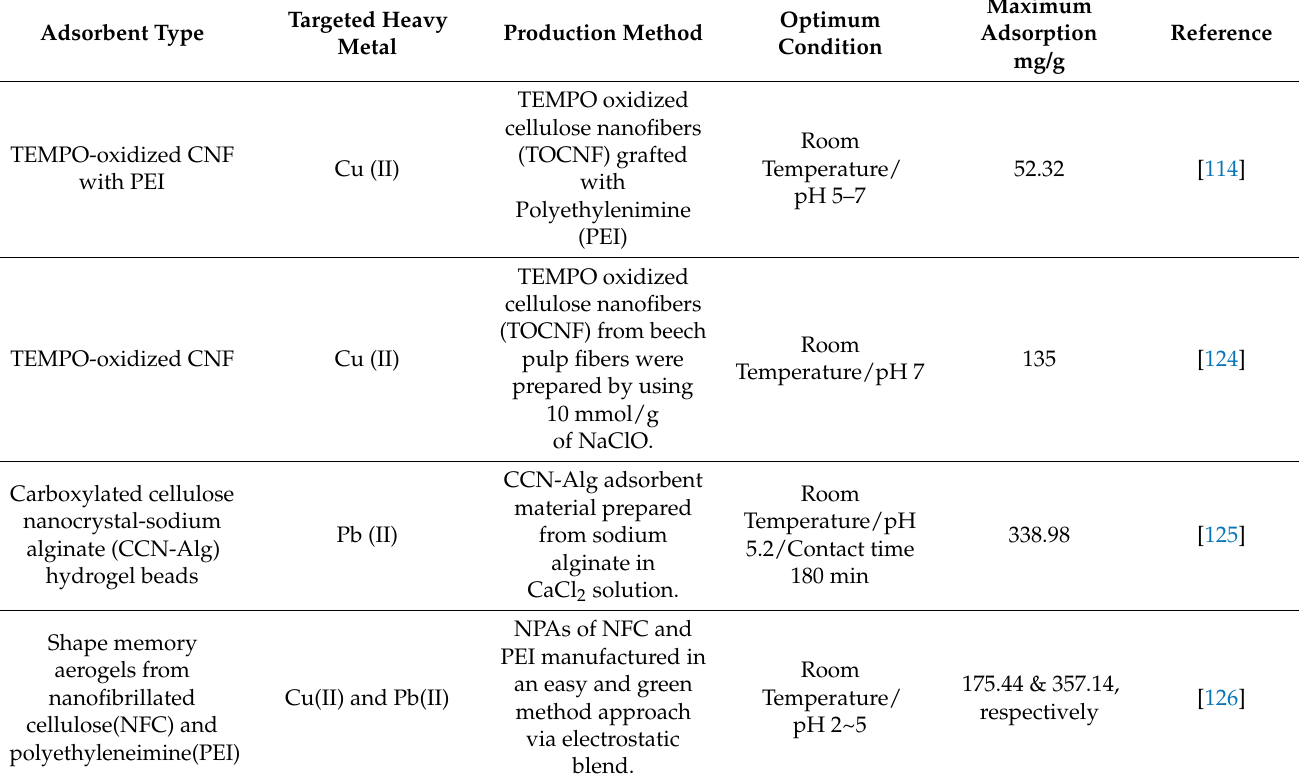
Table 3. Adsorbent based on nanocellulose for the removal of heavy